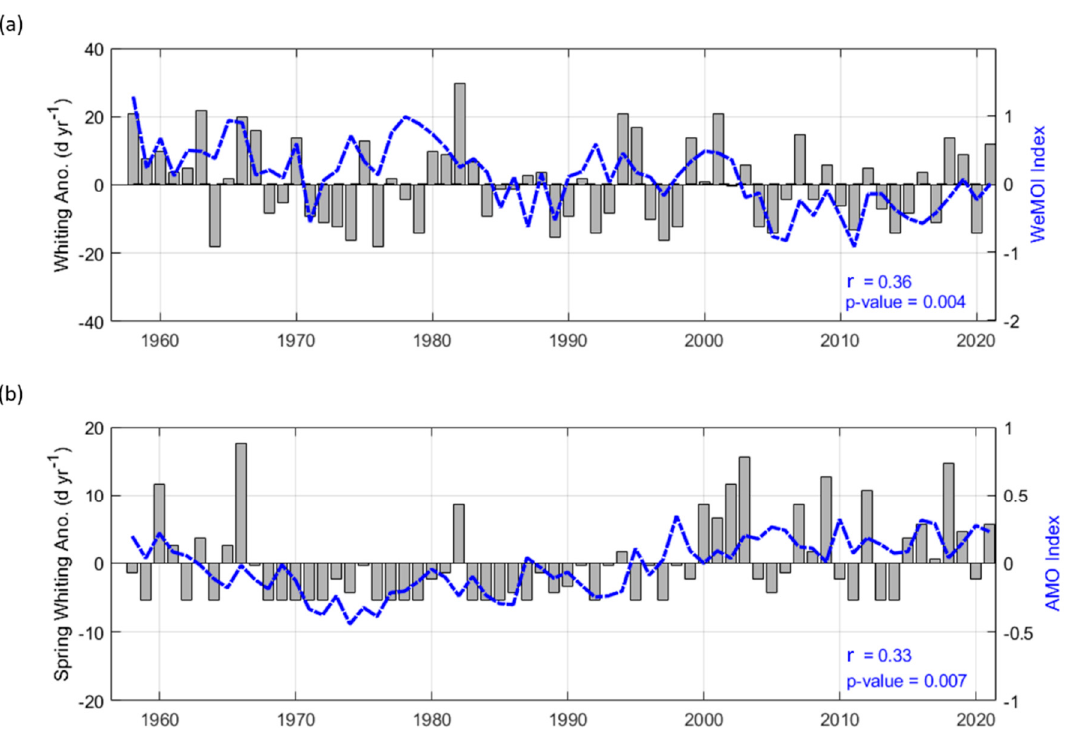
Figure 8. ( a ) Time series of annual predicted whiting events anomalies (class 1) using the RF algorithm and correlated Western Mediterranean Oscillation index (WeMOi, r = 0.36). ( b ) same as ( a ) but for spring whiting days only, correlated with the Atlantic Multidecadal Oscillation (AMO, r = 0.33).